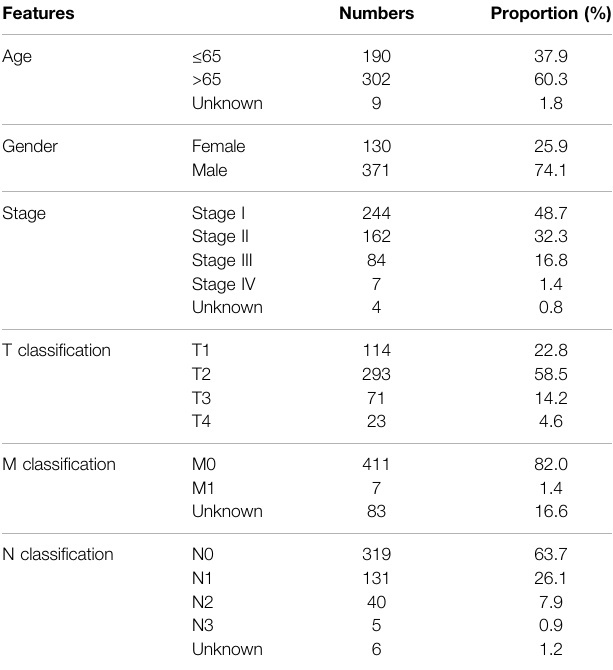
TABLE 1 | Baseline data of the enrolled